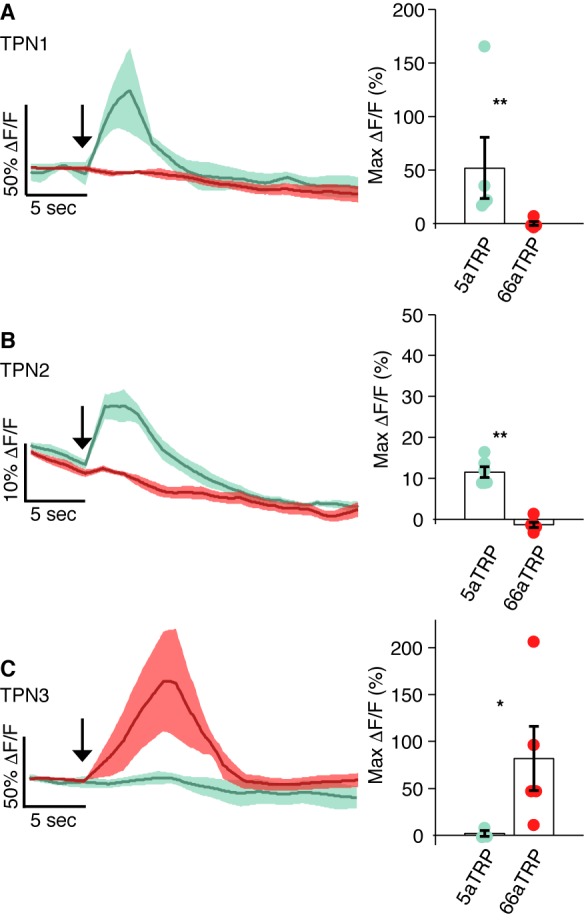
Calcium Imaging of TPNs with ectopic activation of GRNs.Calcium responses in each TPN class were observed using GCaMP5 while a heat-activated channel (LexAop-dTRPA1) was expressed in either sugar GRNs (Gr5a-LexA) or bitter GRNs (Gr66a-LexA). In all panels, left shows trace of average △F/F signal with shaded SEM and right shows max △F/F values. (A) TPN1 shows robust response to heat when dTRPA1 is expressed in sugar GRNs (green), but not bitter GRNs (red) (p=0.0079). (B) TPN2 shows robust response to heat when dTRPA1 is expressed in sugar GRNs (green), but not bitter GRNs (red) (p=0.0022). (C) TPN3 shows robust response to heat when dTRPA1 is expressed in bitter GRNs (red), but not sugar GRNs (green) (p=0.0357). (A–C) Error bars are SEMs. n = 3–6. Statistical tests are Wilcoxon rank-sum.